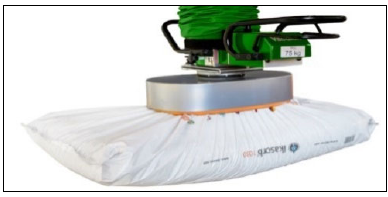
Figure 2. Vacuum lifter.